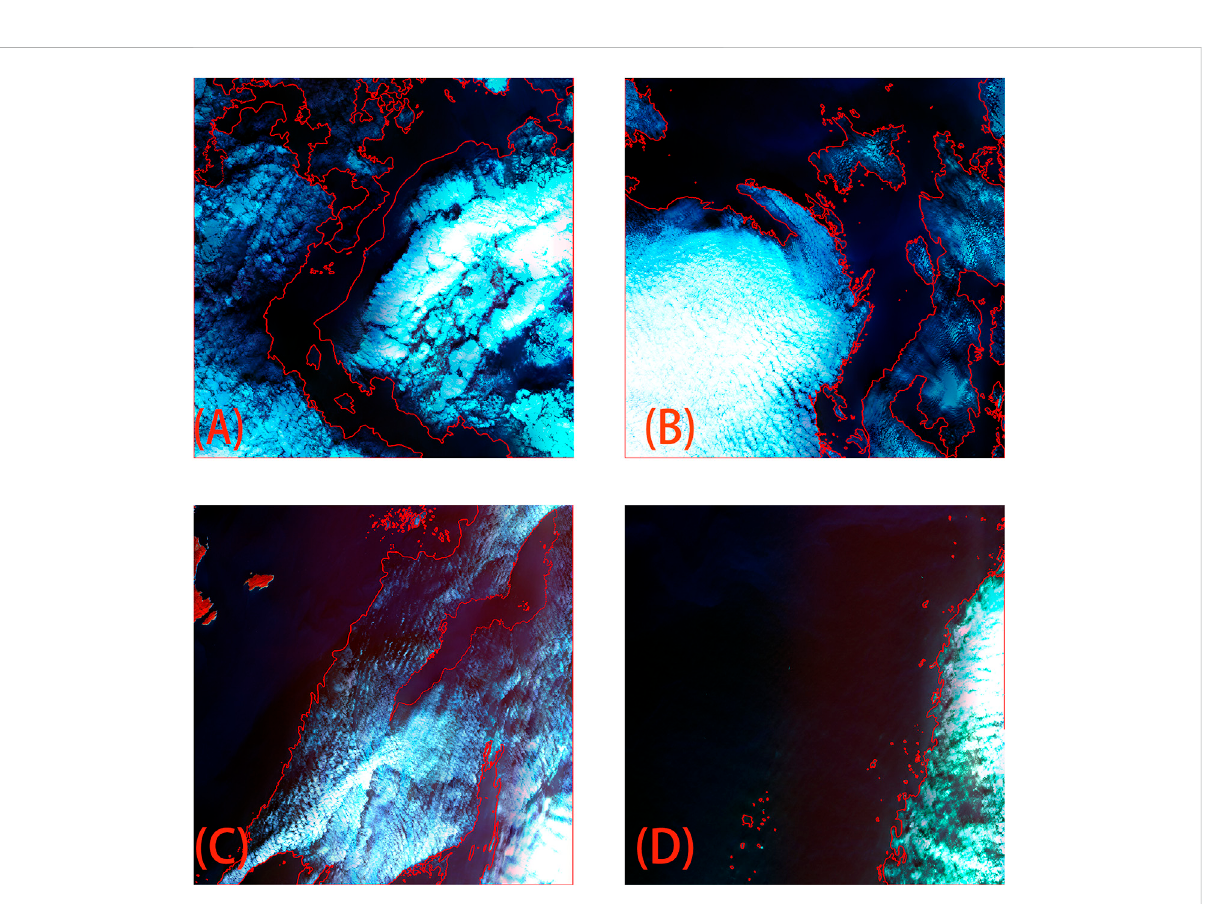
FIGURE 1 Hyperspectral image of the cloud detection (false Color Composite image of bands 26, 13, 6 in RGB, the red vector is the visually interpreted cloud boundary). Image acquisition date (A) 2021/1/5; (B) 2021/1/22; (C) 2021/1/19; (D)